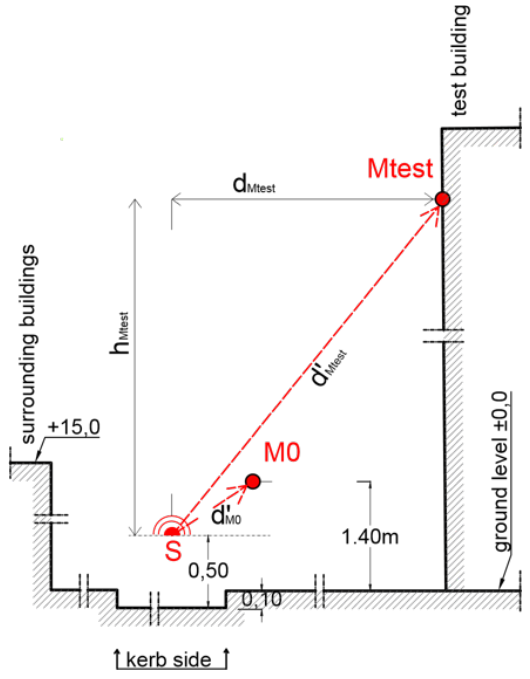
Figure 11: Typical site layout. M0: reference point, S: sound source (equivalent line of traflc in the middle of road width)